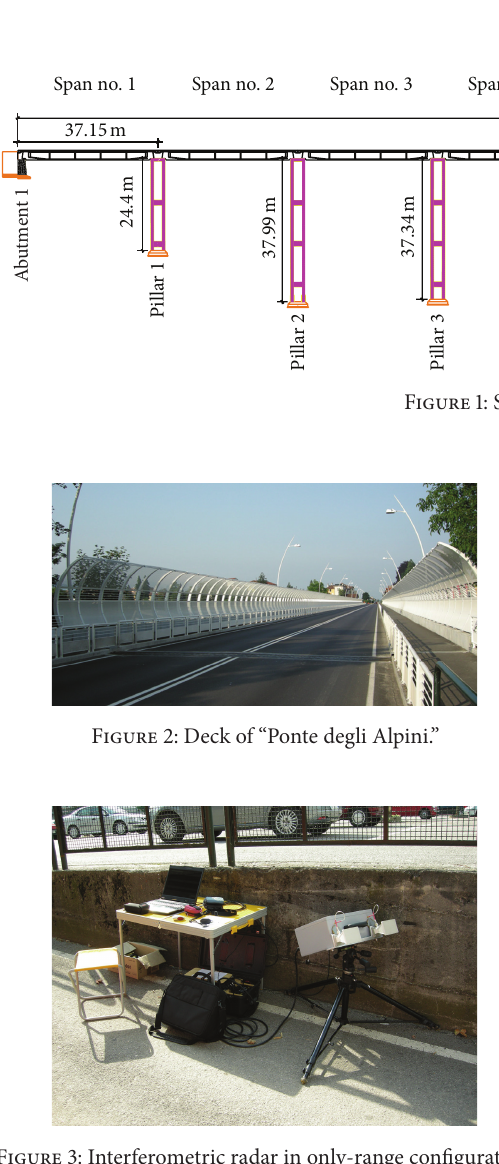
Figure 3: Interferometric radar in only-range configuration.